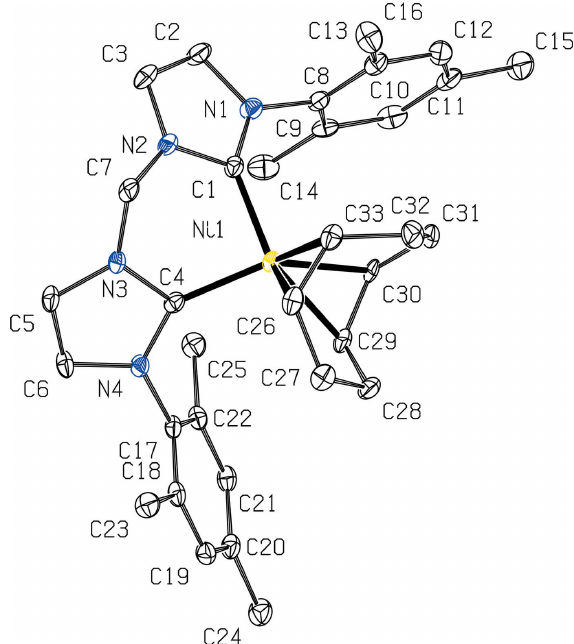
Figure 2 View of one molecule of ( Mes NHC 2 Me)Ni(COD) with 50% probability ellipsoids. The THF molecules and H atoms are omitted for clarity.